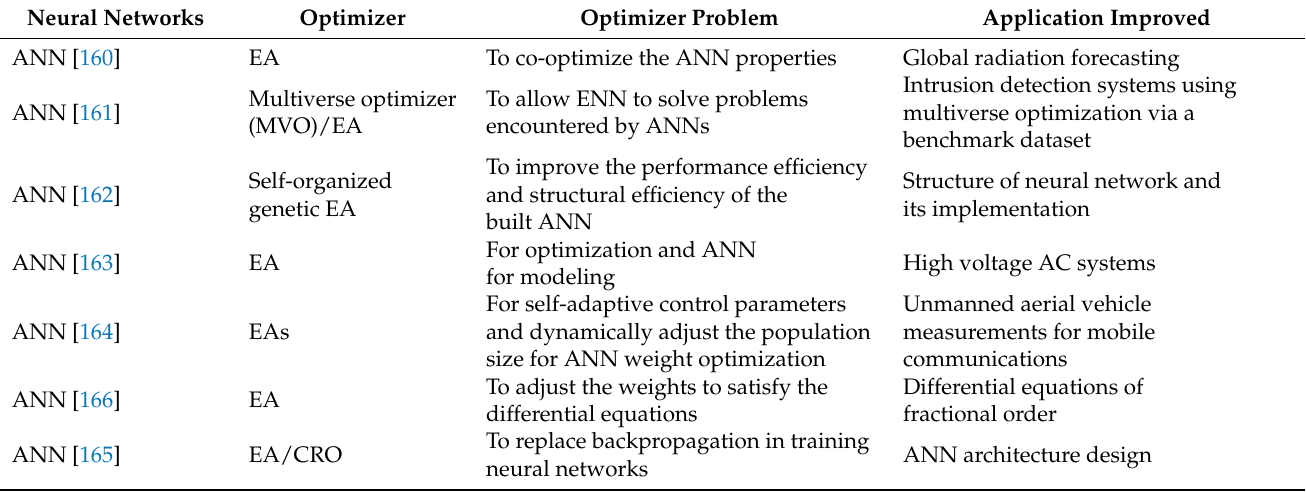
Table 6. Studies involving EA for neural networks design and application